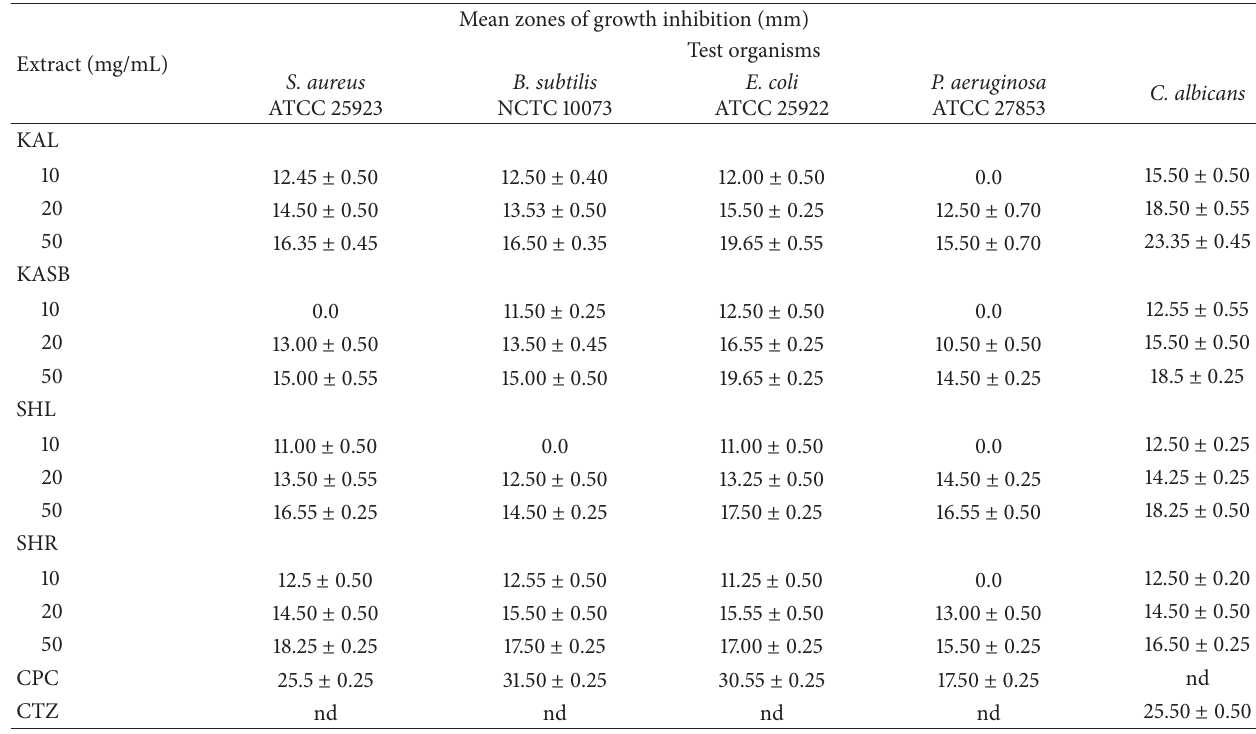
Table 3: Antimicrobial activity of methanol leaf extract (KAL) and stem bark extract (KASB) of K. africana and leaf extract (SHL) and root extract (SHR) of S. hispidus by agar diffusion method . Mean zones of growth inhibition (plus diameter of well) are mean (mm) of 3